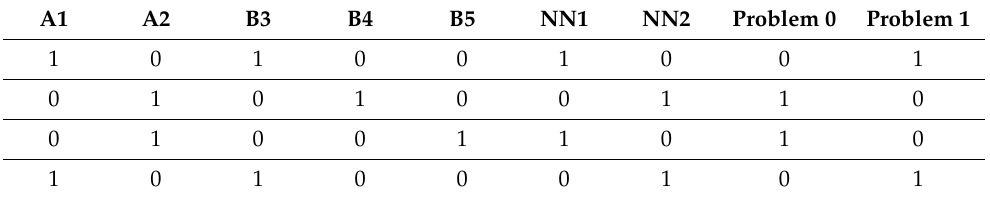
Table 2. Example from Table 1 transformed with one-hot encoding before computing the PMI values.